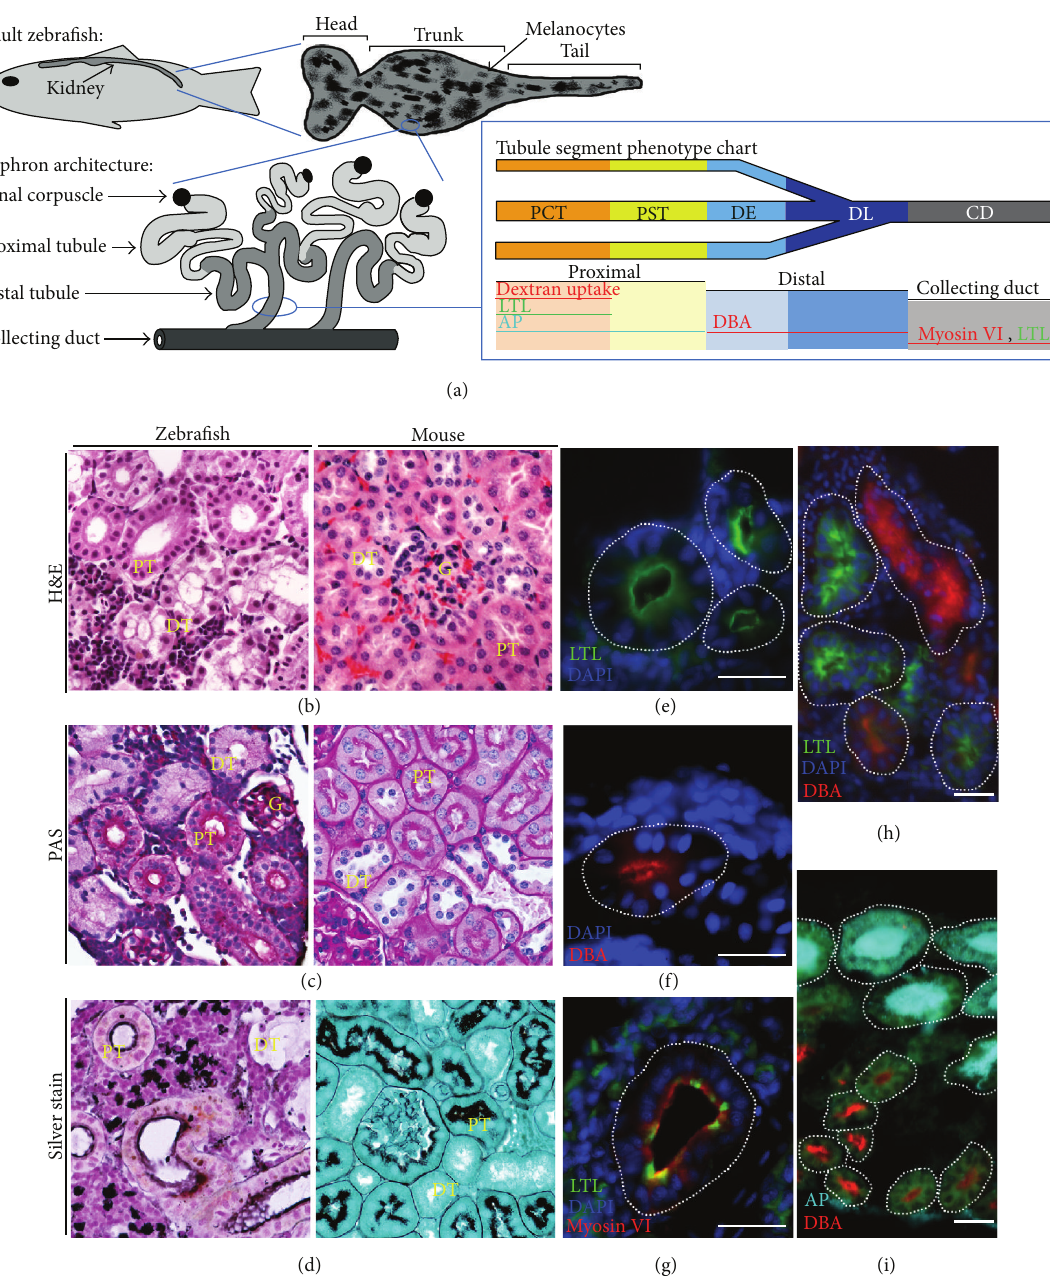
Figure 1: Anatomy of the zebrafish kidney and the identification of histological stains to distinguish renal structures. (a) The adult zebrafish kidney is comprised of arborized arrangements of nephrons that share common distal late tubule segments and drain into major collecting ducts (schematic adapted from [32]). ((b)–(d)) Histological staining in the zebrafish kidney revealed similarities to that of mammalian organ structure. (b) H&E and (c) PAS staining of wild-type zebrafish and mouse kidney tissue emphasized the brush border and elongated cells characteristic of the proximal tubule (PT, yellow label) compared to the pale pink hue of the distal tubule (DT, yellow label). Blood filters or glomeruli (G, yellow label) were as indicated. (d) Silver staining highlighted the brush border in a deep brown hue and additionally stained hyaline droplets located in the PT, while DT structures lacked the brown labeling. Zebrafish tissue sections 60x, mouse tissue sections 40x. ((e)–(i)) Fluorescent labeling of zebrafish tubules and collecting duct, with perimeters of each respective structure outlined in white dots, and nuclei ((e)–(h)) labeled with DAPI. Scale bars, 25 𝜇 m. (e) LTL (green) stained the PT, while (f) DBA (red) stained the DT, and these tubule populations are mutually exclusive (h). (g) LTL also stained the collecting ducts, which were distinguished by a myosin VI antibody. (i) In transgenic Tg:enpep:egfp zebrafish, PT structures labeled with ELF-97 to detect alkaline phosphatase were mutually exclusive to DBA-stained distal tubules, and tubules were identified by labeling with anti-eGFP (representative panel reprinted with permission from